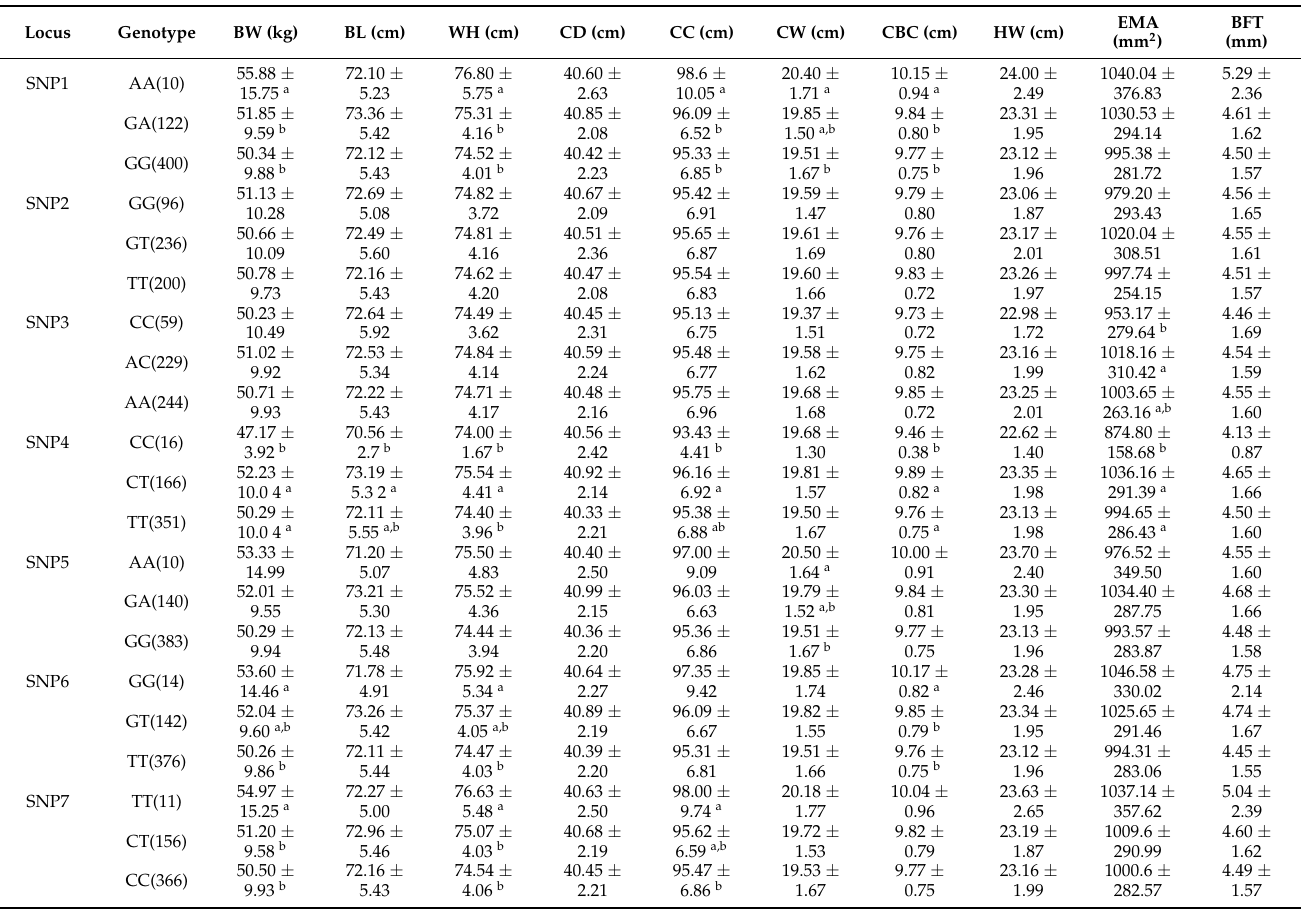
Table 4. Association between mutations in MYF5 with body measurements and ultrasound